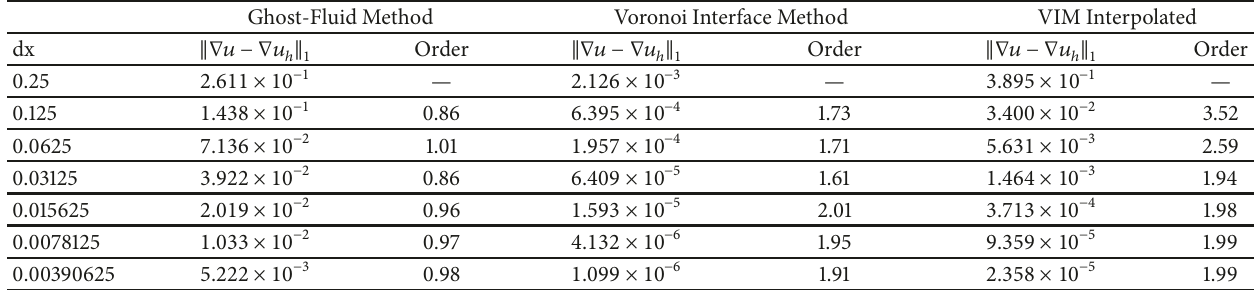
Table 8: Comparison of the 𝐿 1 error in the gradient of the solution for the Ghost-Fluid Method and the Voronoi Interface Method, for example, shown in Section